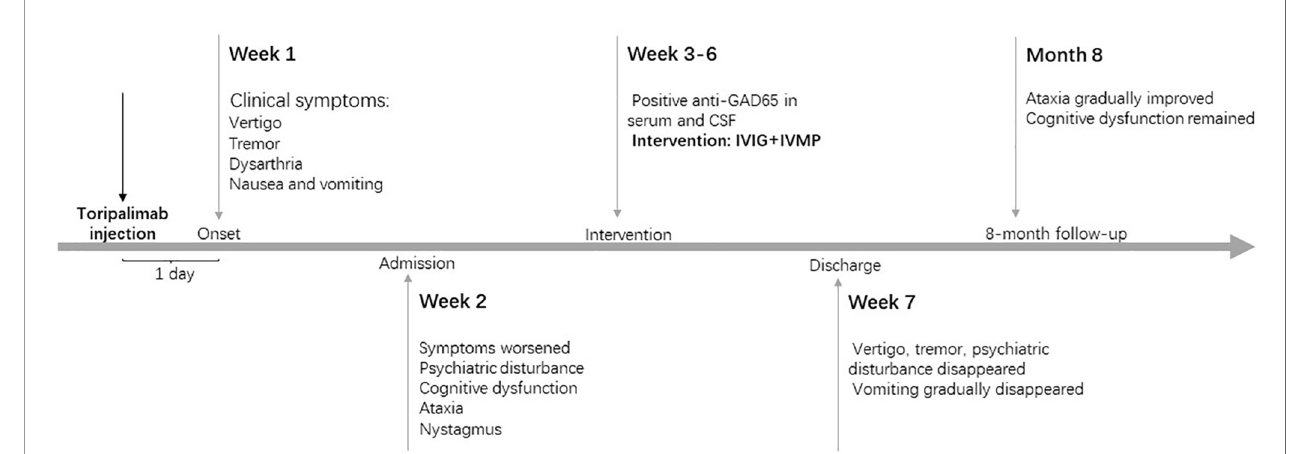
FIGURE 1 | Timeline of patient with relevant data of the episodes and interventions. IVIG, intravenous immunoglobulin; IVMP, intravenous